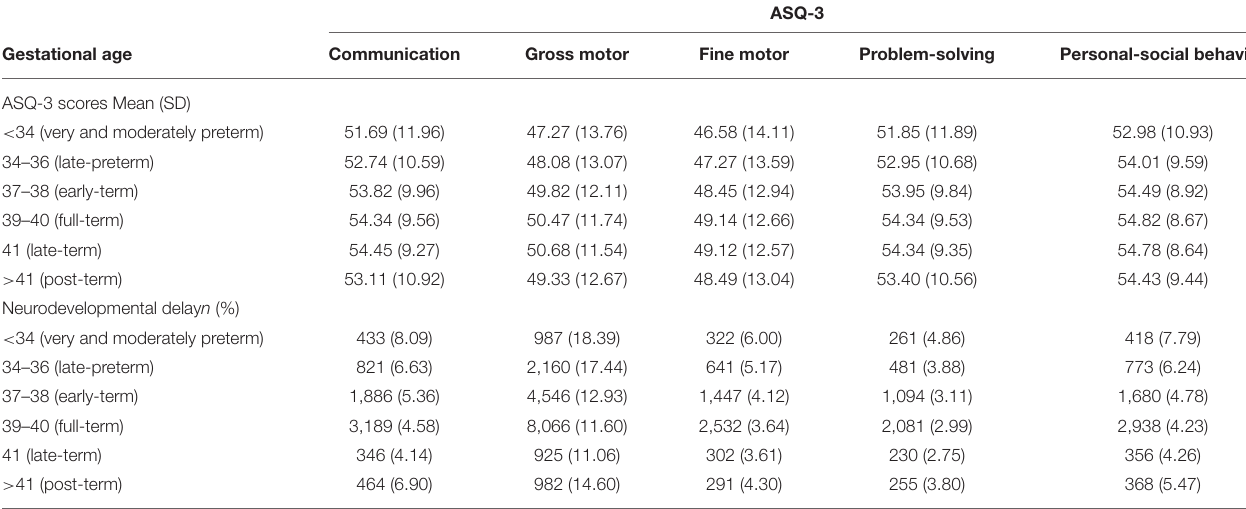
TABLE 2 | ASQ-3 scores for each domain sorted by gestational age at birth ( n = 137,530).